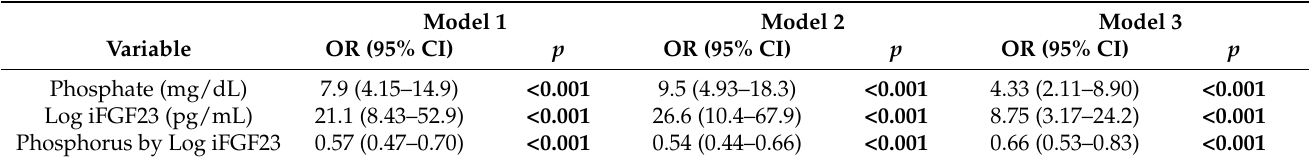
Table 2. Multivariate logistic regression analysis results of the association between iFGF23, phosphate and their interaction, and the presence of